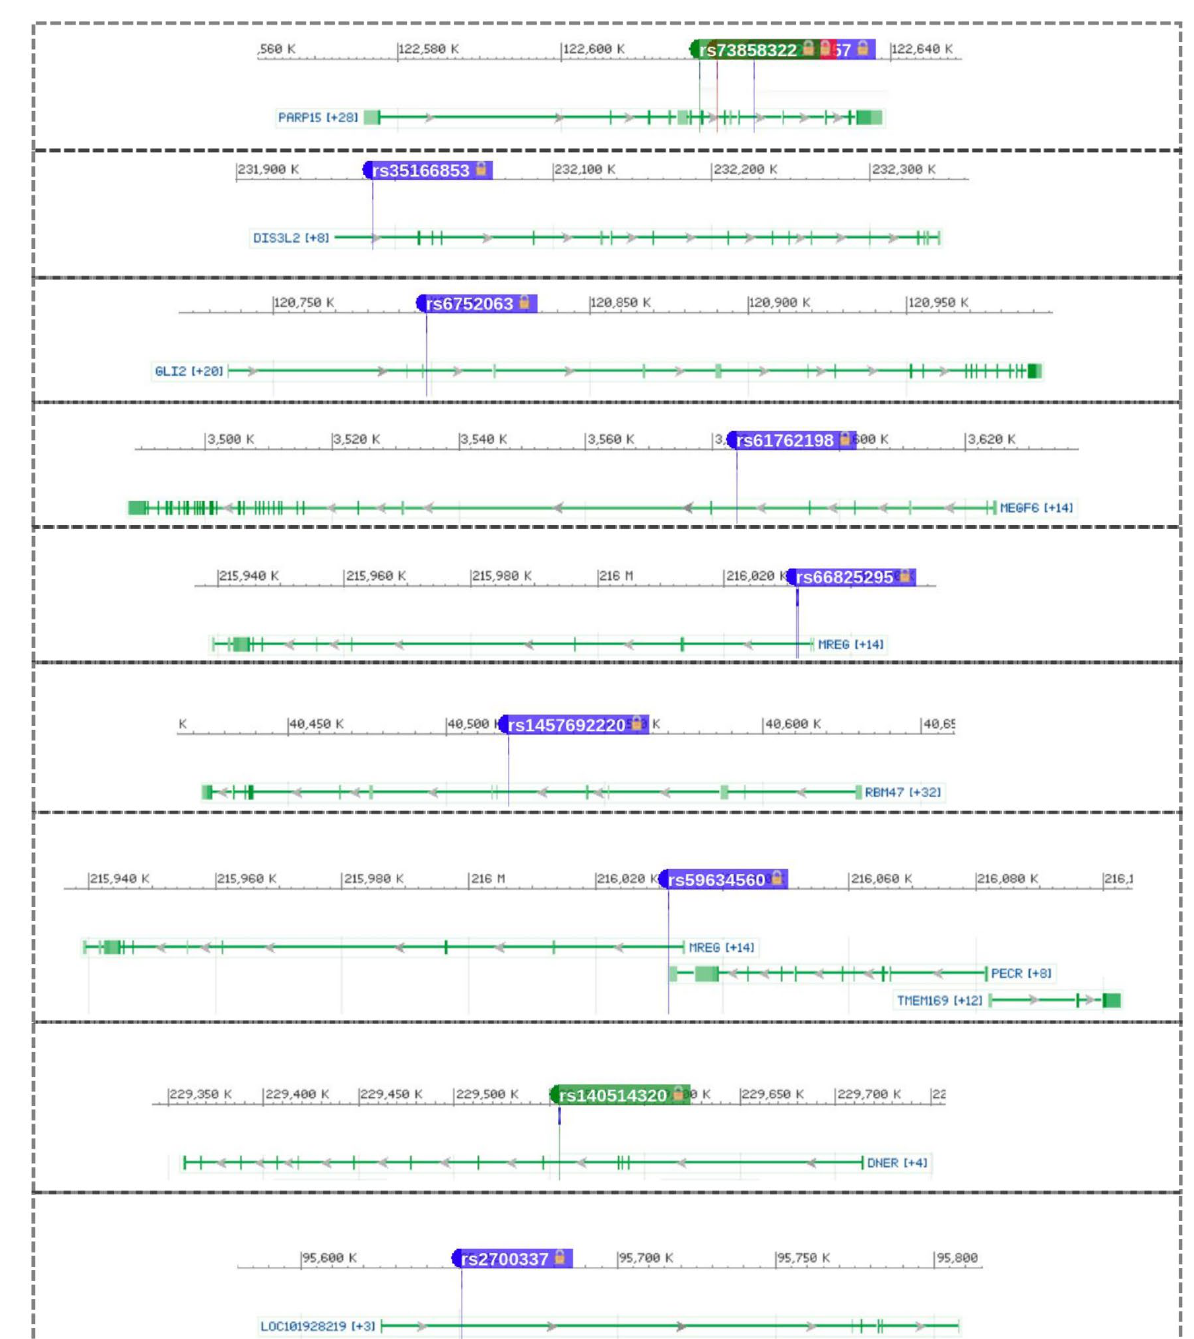
Figure 6. Graphical representation of the location of some SNPs linked to hypertension. The physical location of several SNPs discovered to be associated with hypertension using GWAS analysis.